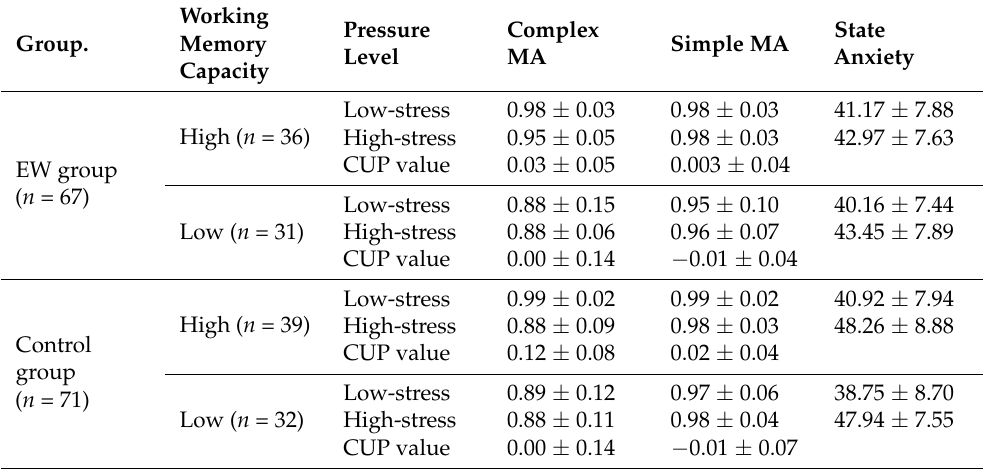
Table 2. MA task accuracy and state anxiety of subjects in the EW and the control group (M ± SD).